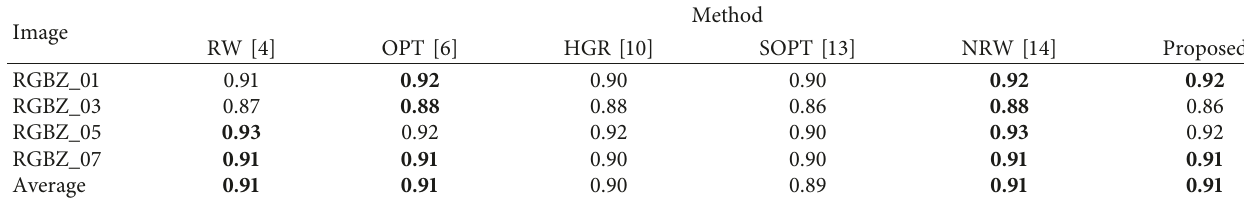
Table 1: SSIM comparison in the absence of inaccurate scribbles.